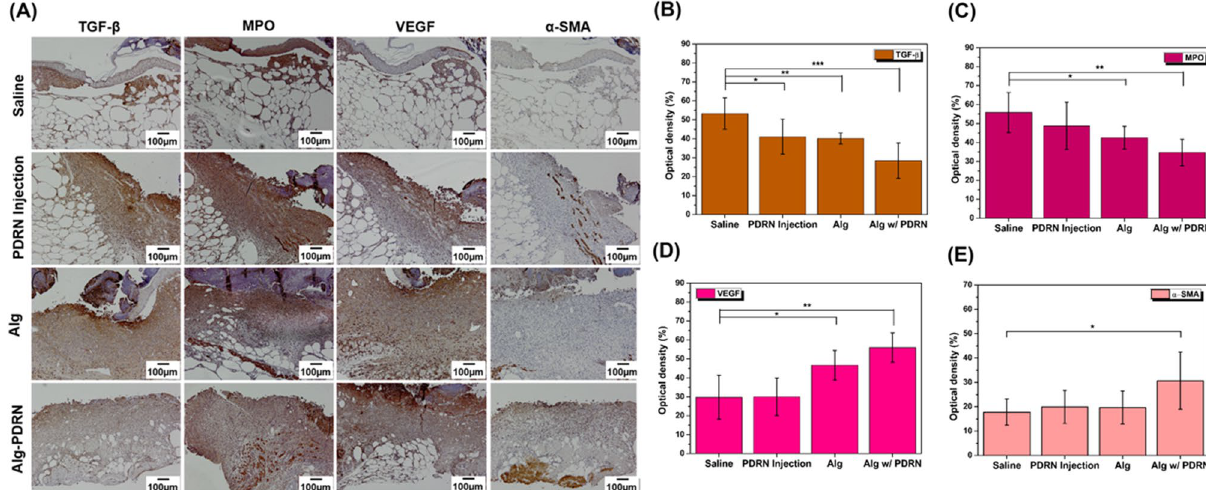
Figure 8. Immunohistochemistry of the wound region after 14 days of treatment: ( A ) representative images of TGF-β, MPO, VEGF and α-SMA stained images of the wound region and quantitative analysis of ( B ) TGF-β, (C) MPO, (D) VEGF and (E) α-SMA (scale bar = 100 µm, * p < 0.05, ** p < 0.005, *** p <